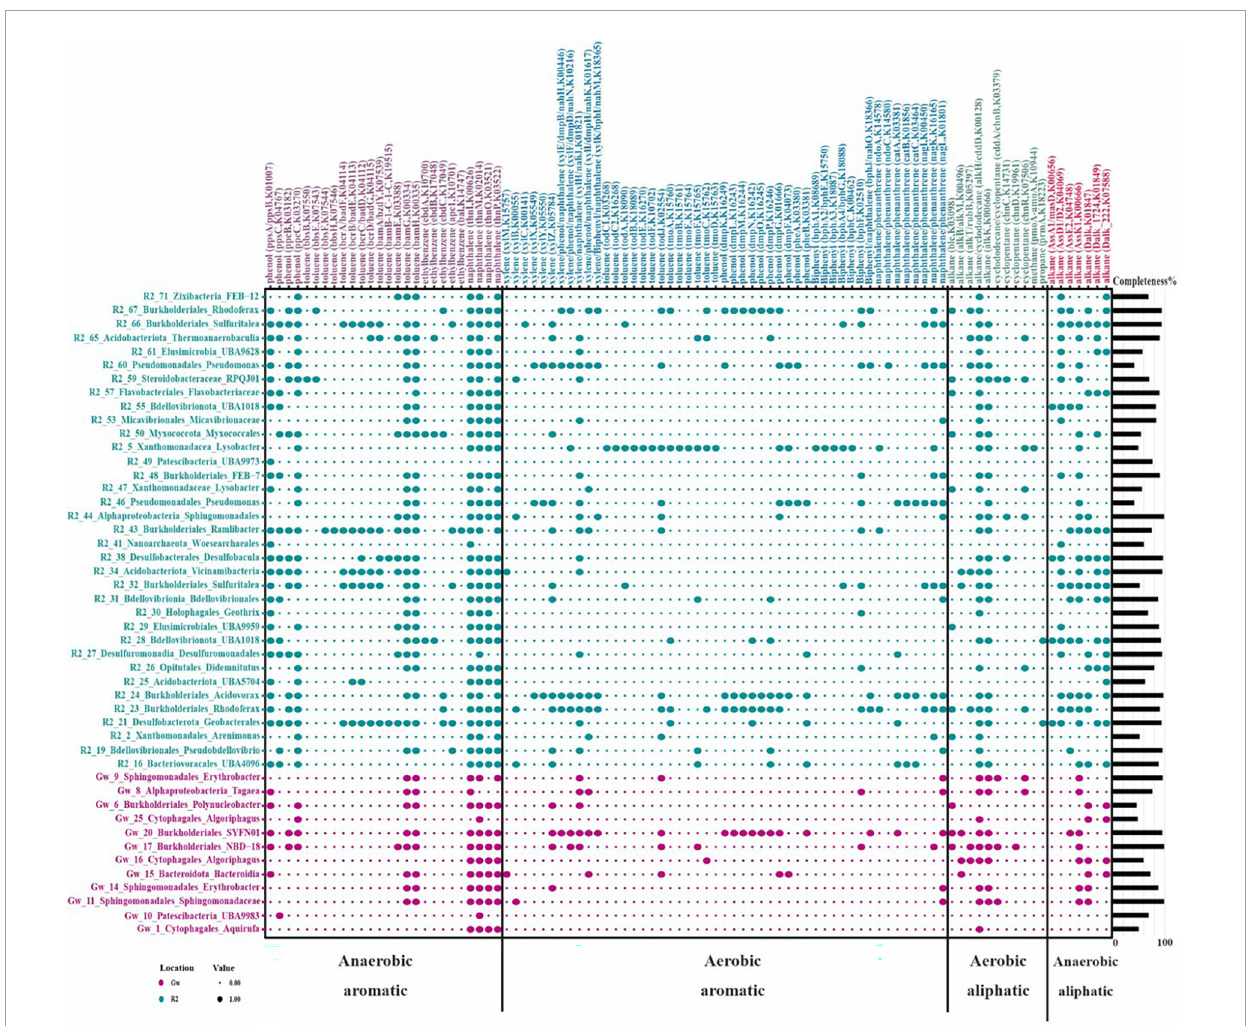
FIGURE6 Hydrocarbon-degrading enzymes present in recovered MAGs from the groundwater metagenomes. Row names represent the taxonomy of recovered MAGs and their completeness is provided as a bar plot on the right side. The color indicates the MAG origin. Columns indicate the type of hydrocarbon and in the parenthesis is the name of the enzyme hydrolyzing this compound, followed by its corresponding KEGG orthologous accession number. The size of the dots indicates the presence or absence of each enzyme in each recovered MAG. The figure was plotted using the “reshape2” and “ggplot2” packages in